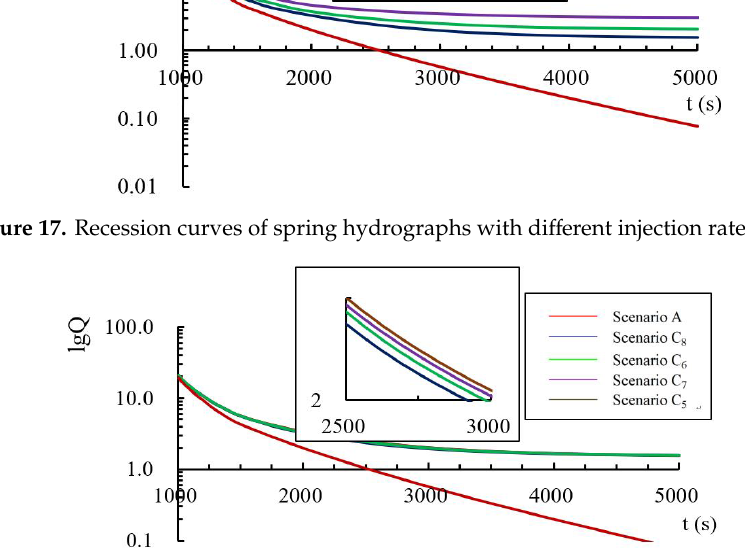
Figure 18. Recession curves of spring hydrographs with injection at wells.